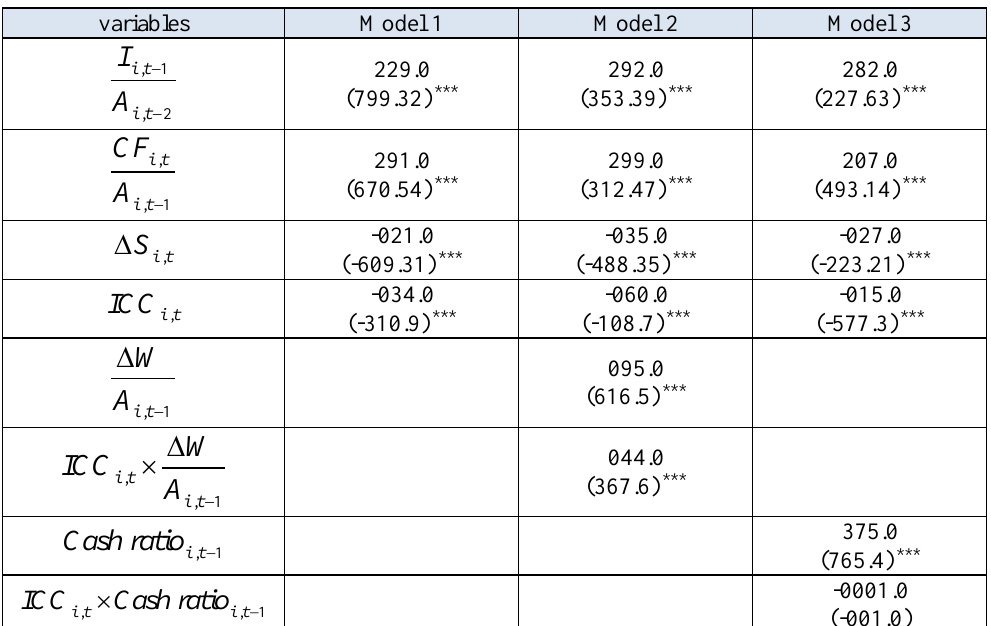
Table 5. Results of research model